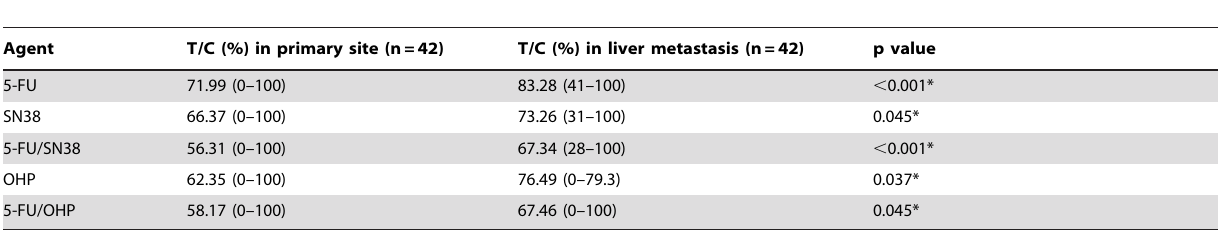
Table 4. Comparison of chemosensitivity between primary site and liver metastasis in CD-DST.